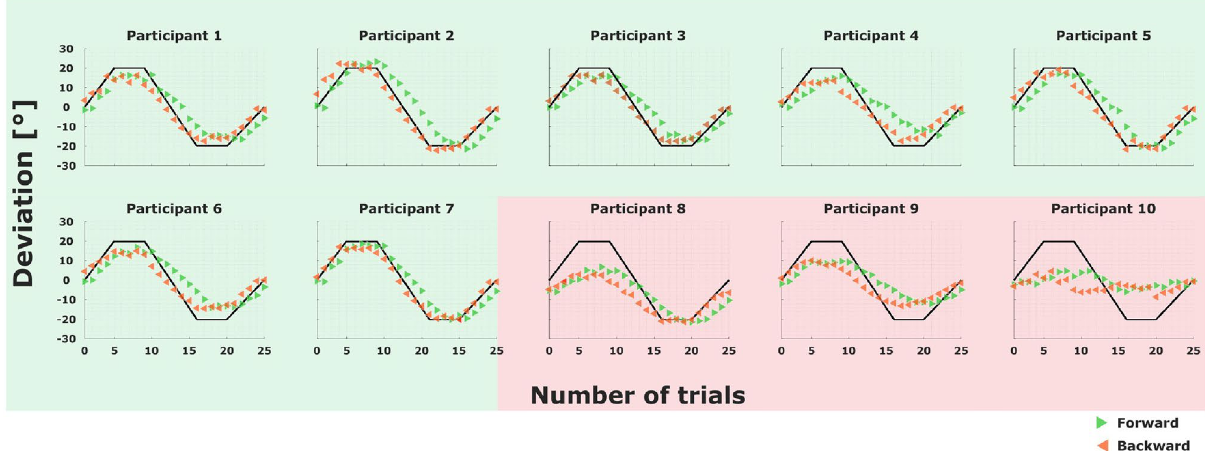
Figure 3. Hysteresis effect. The filled triangles are the mean of the observed angles for every deviation in both the forward process, in green, and the backward process, in red. The black line is the forward protocol. Note that we have mirrored the triangles for the backward process to make them coincide with those in the forward process that are exposed to the same true angle. Participants that achieve at least 50% adaptation are shaded by a green background color. Hysteresis can be observed between trials 1 and 5, 9 and 17 and 21 and 25. Notice, as expected, the forward means are below the backward in the first region, above in the second and below again in the third.